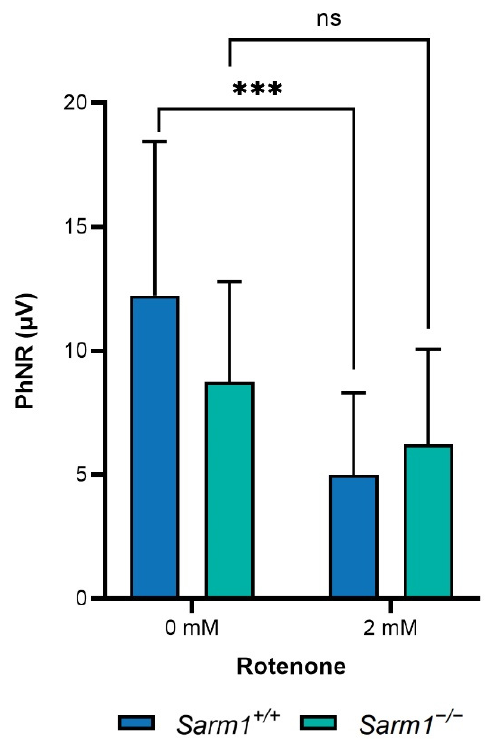
Figure 2. Analysis of PhNR. Rotenone was delivered via intravitreal injection. PhNRs were measured six weeks post-injection. Bar charts represent the mean PhNR. Error bars represent SD, *** p < 0.001, ns = non-significant. Reduction in PhNR following rotenone treatment was significantly greater in wild type Sarm1 +/+ mice (12.23 ± 6.22 µ V vs. 5.01 ± 3.3 µ V; p < 0.001) than Sarm1 − / − mice, where the reduction was not significant (8.75 ± 4.04 µ V vs. 6.23 ± 3.85 µ